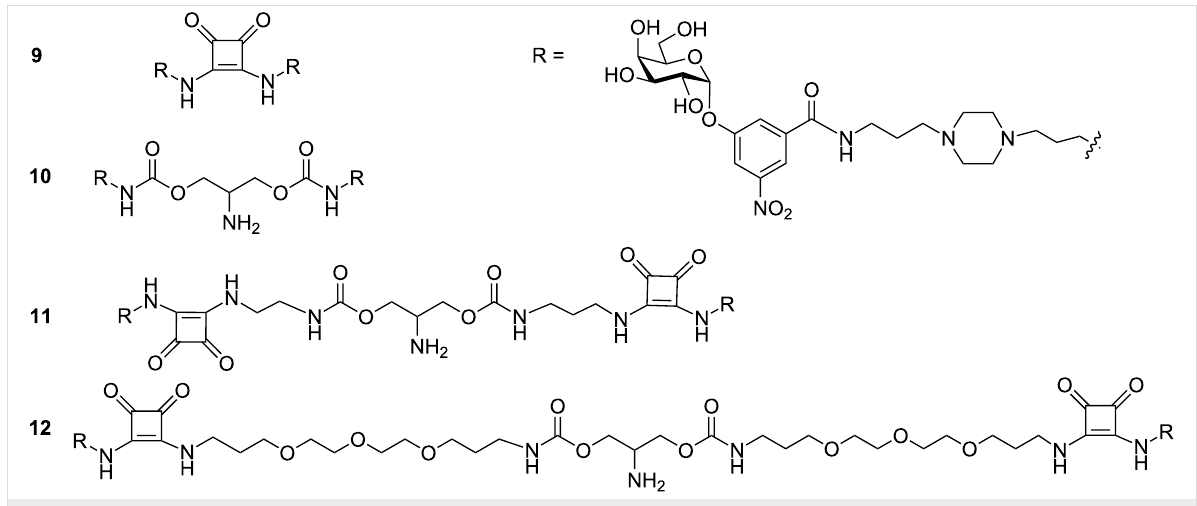
Figure 5: Bivalent inhibitor designed and synthesised by Pickens et